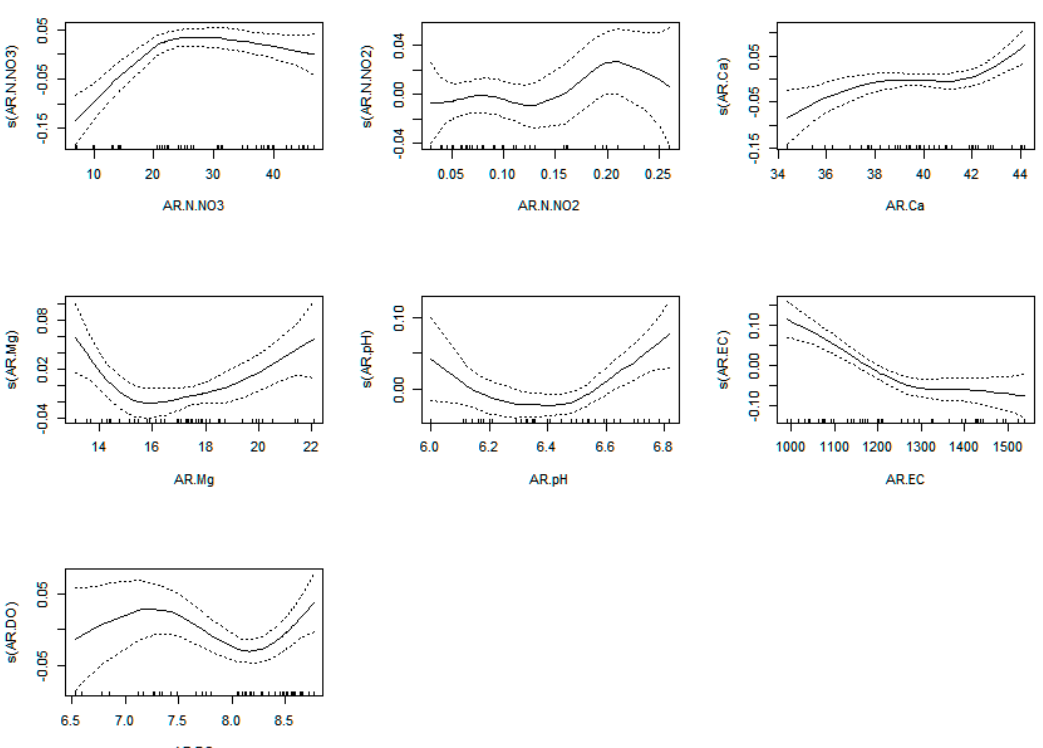
Figure A14. The GAM predictors influence over N-NH 4 for AH experimental variant.